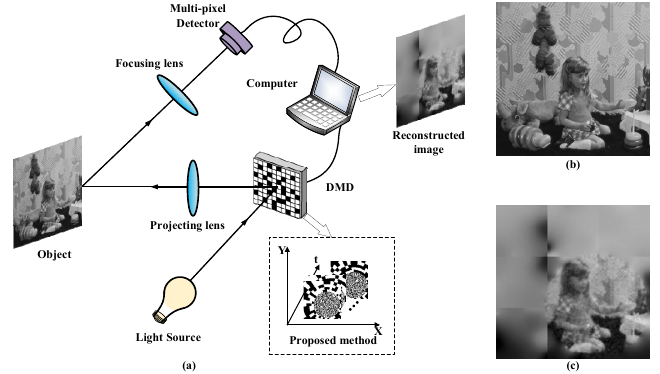
Figure 1. Principle of the PRGI ( a ) PRGI; ( b ) Original image; ( c ) Reconstructed image.